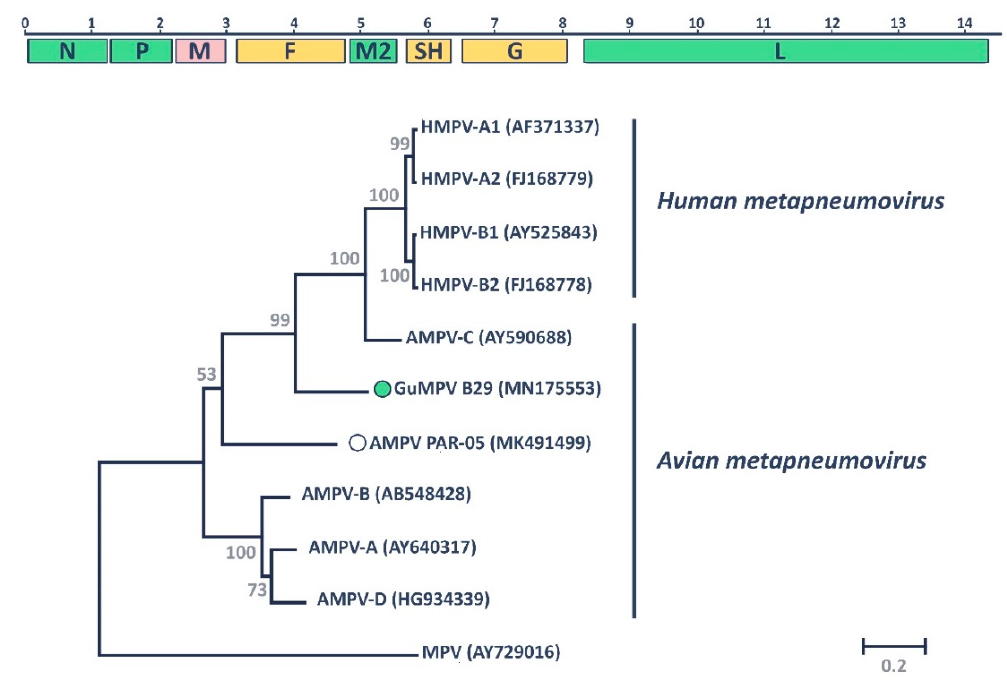
Figure 1. Molecular characteristics of GuMPV B29. The genome organization of the novel virus is depicted at the top. Identified open reading frames (ORFs) are illustrated by colored rectangles: Nonstructural proteins are in green (N: nucleoprotein; P: phosphoprotein, L: polymerase), envelope glycoproteins are in yellow (F: fusion protein; SH: small hydrophobic protein; G: glycoprotein), and the matrix protein (M) is in pink. The scale bar on top represents genomic position in Kb. The phylogenetic placement of GuMPV B29 within the genus Metapneumovirus based on the complete amino acid sequence of the L protein is shown at the bottom. The two species Human metapneumovirus (AMPV) and Avian metapneumovirus (AMPV) are indicated on the right, and the murine pneumovirus (MPV) was used as an outgroup. Accession numbers are indicated in parentheses. Officially assigned viral sub-groups are indicated by letters (A1-2, B1-2 for HMPV, A–D for AMPV), while recently identified viruses that lack official taxonomic designations are indicated by circles with the virus identified in this study indicated by the filled green circle. The tree was built with the maximum likelihood method [47] using MEGA 7 [43] based on the Le Gascuel model [49], identified as the best-fitting model by the model test in MEGA. A discrete Gamma distribution was used to model evolutionary rate differences among sites, branch lengths are proportional to genetic distances as indicated by the scale bar, and the outcome of the bootstrap analysis [48] is shown next to the nodes.